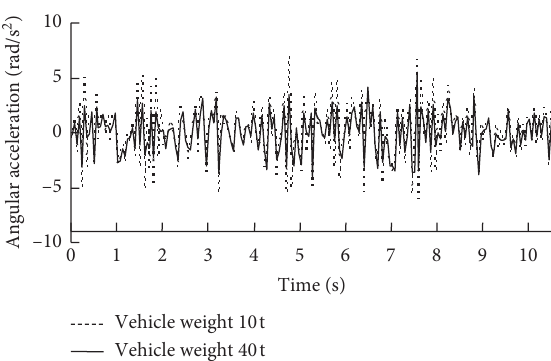
Figure 24: The time-history curves of rolling vibration accelerations of the vehicle body.